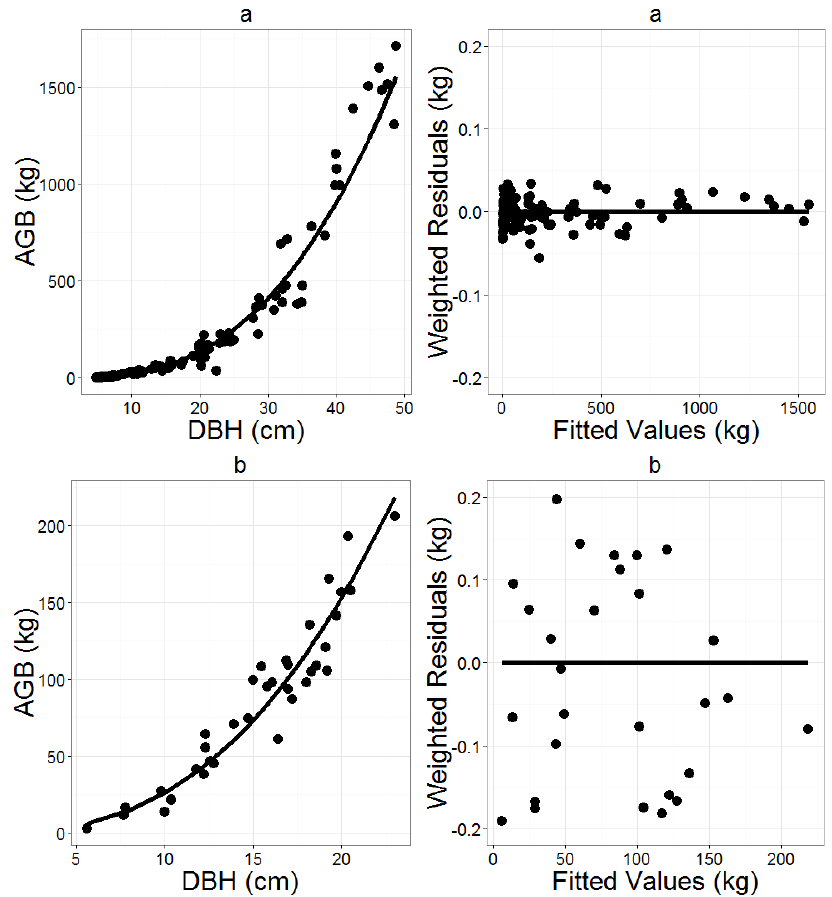
Figure 5. Plots of fitted values vs. DBH ( left ) and fitted values vs. weighted residuals ( right ) of the selected model AGB = a × DBH b for two main genera: ( a ) Dipterocarpus (the entire dataset, n = 94 trees), and ( b ) for Shorea (the entire dataset, n = 36 trees).